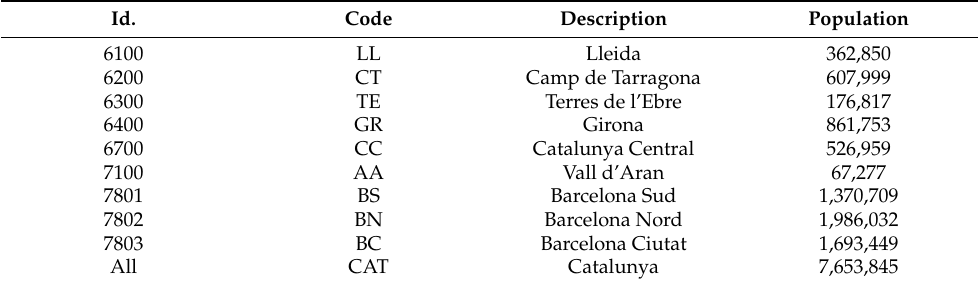
Table 2. Catalonia Health